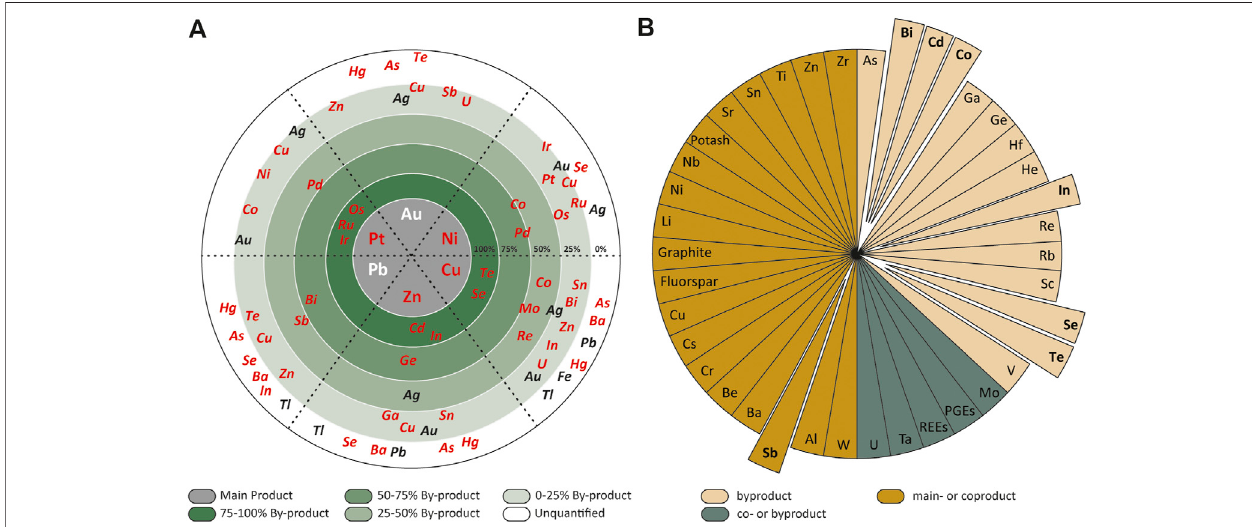
FIGURE 1 | (A) The wheel of metal companionality for select base and precious metals (after Nassar et al., 2015; Jowitt et al., 2018) which shows the relationship between primary metal (the central part of the wheel) and by- or coproduct elements and their percentage of production with critical elements highlighted in red. (B) Critical elements categorized by their byproduct, coproduct and main product nature (adapted from Huston, 2021). The critical elements investigated in this study are Sb, Bi, Cd, Co, Se and Te.